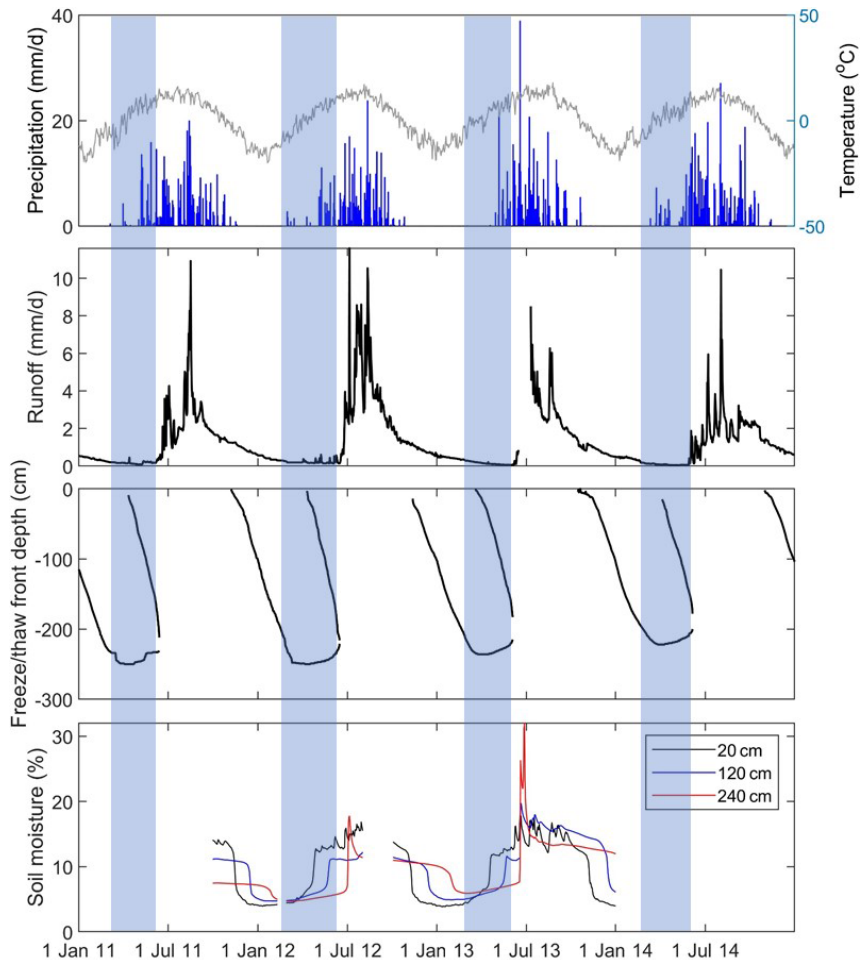
Figure 3. Observed daily precipitation and air temperature, observed daily runoff depth of the Hulu catchment, observed freeze/thaw front depth, and observed soil moisture at depths of 20, 120, and 240cm are